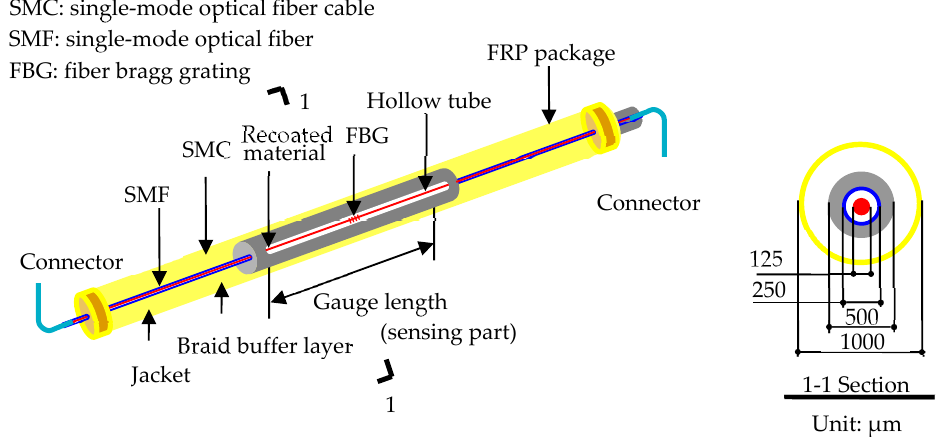
Figure 1. The structural design of the packaged LFBG sensor proposed by Li [42].